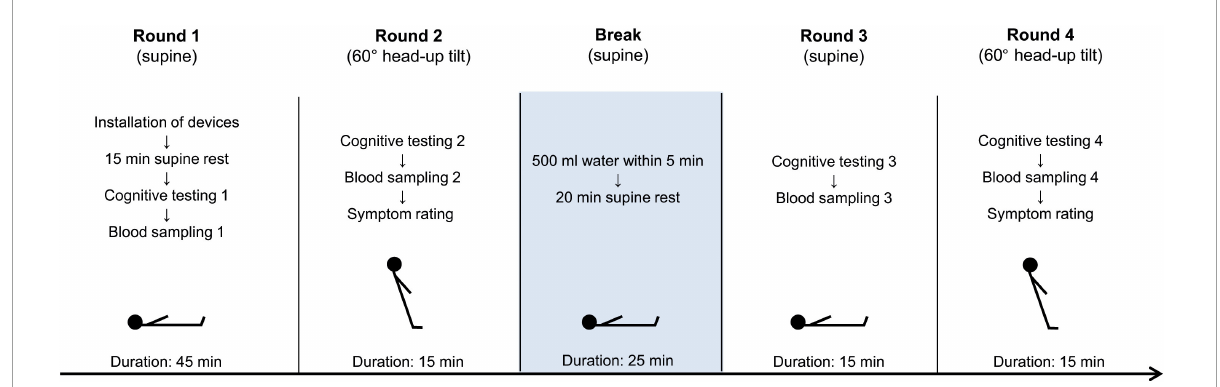
FIGURE1 Study protocol. Participants completed four rounds of cognitive testing (test “Sustained Attention” from the test battery “Test of Attentional Performance”). Blood samples for catecholamine assessment were taken four times, each time in the last minute of the test. After each head-up tilt phase, all participants rated ten of the most frequent symptoms of orthostatic intolerance.